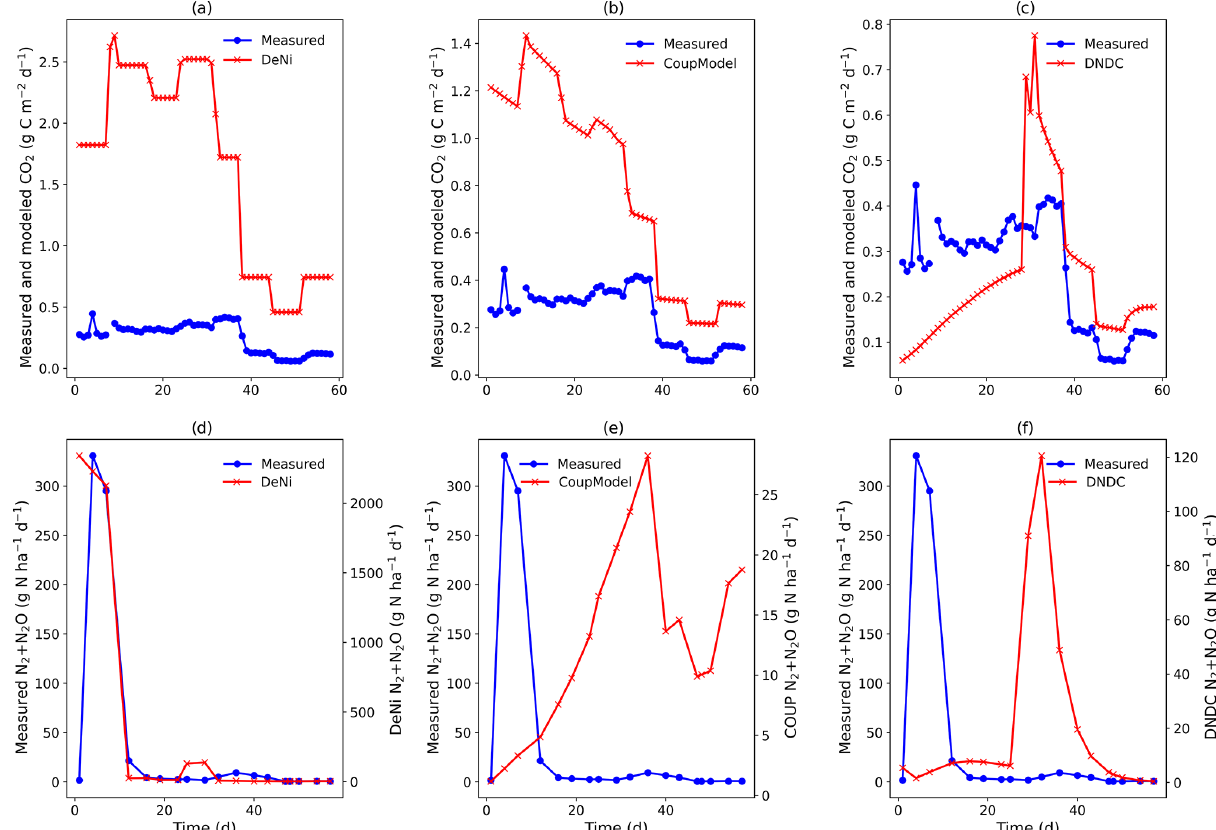
Figure 2. (a–f) Measured and modeled (DeNi, Coup and DNDC) CO 2 and N 2 + N 2 O fluxes from a 58d laboratory incubation of soil cores from a sandy, arable site in Fuhrberg, Germany. Measured values shown are the average of the control cores (cores 5–8), which were given no additional